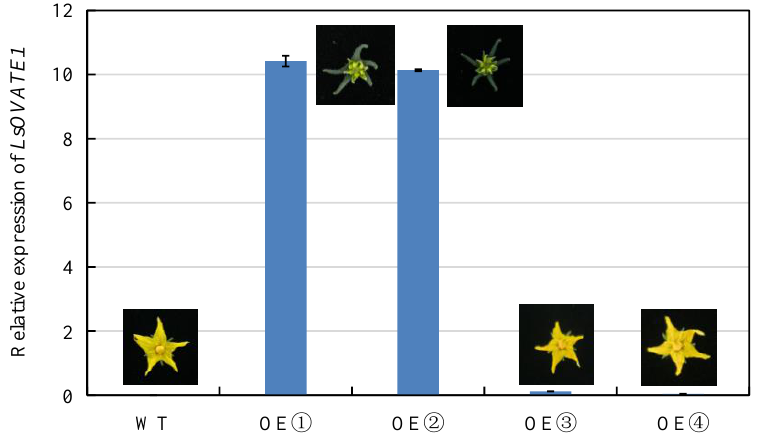
Figure 9. LsOVATE1 expression levels in overexpressing and wild-type plants. Relative expression of LsOVATE1 in wild-type (WT) tomato and four overexpressing tomatoes (OE ➀ , OE ➁ , OE ➂ , OE ➃ ). Values are means ± SD of three replicates.